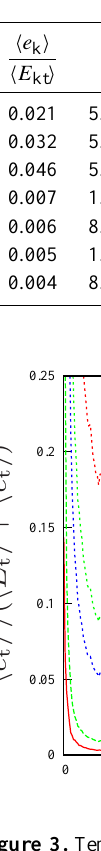
θ t , and Eq. (32) at selected vertical ( xz ) and horizontal ( xy ) planes for three levels of forcing (runs W02, M02, and